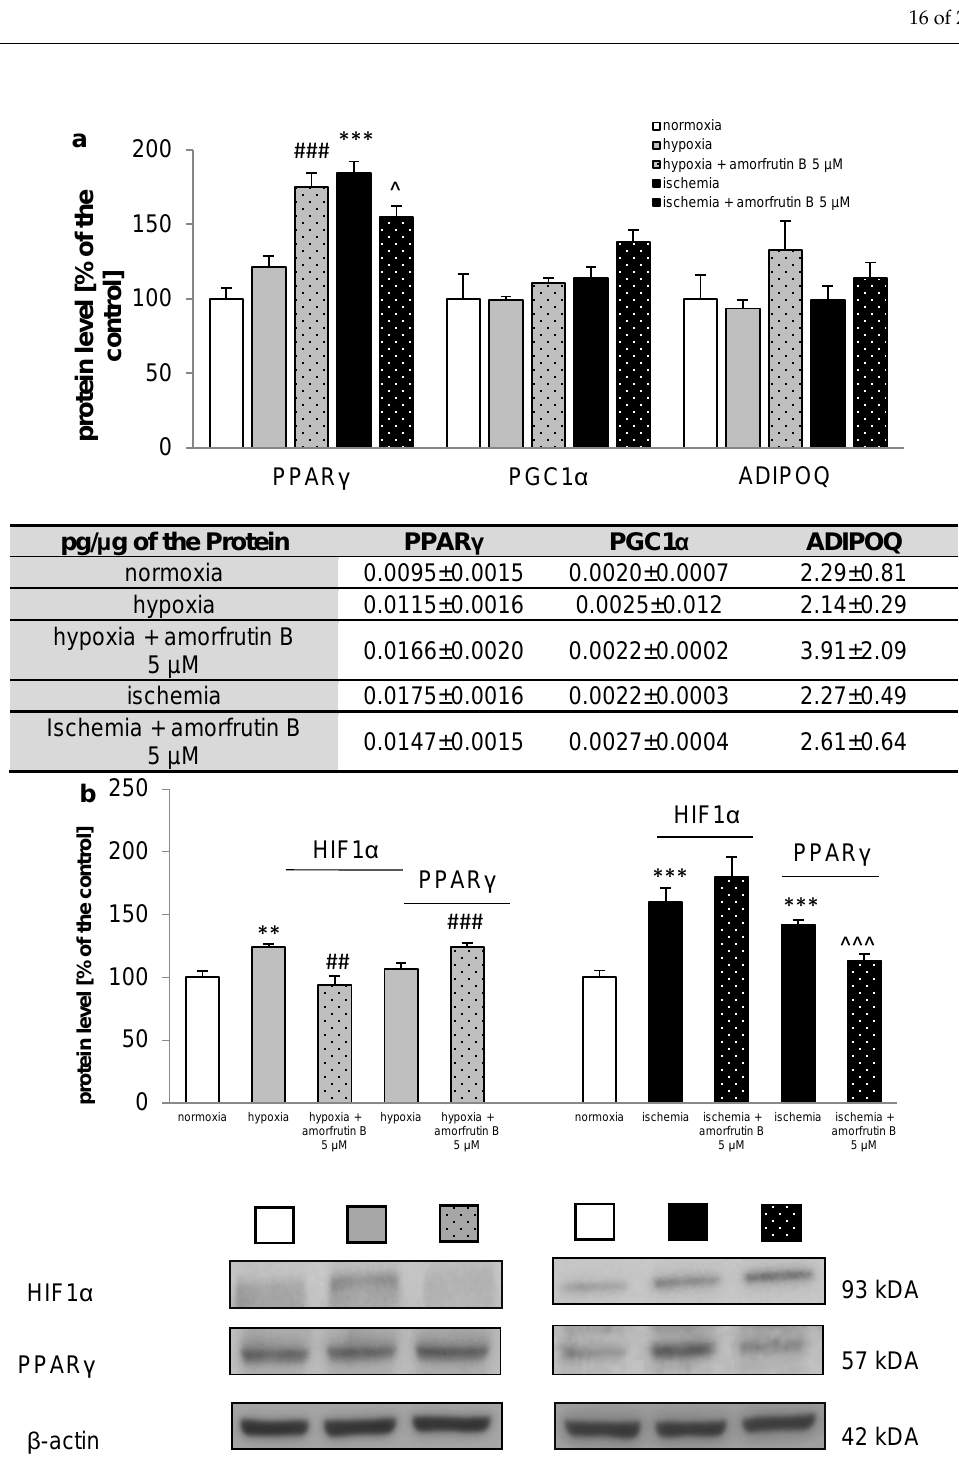
Figure 7. ELISA ( a ) and Western blot ( b ) showed that hypoxia or ischemia and amorfrutin B (5 µ M) post-treatment changed the protein expression levels of HIF1 α and PPAR γ but did not affect the protein expression levels of PGC1 α and ADIPOQ. The results are presented as a mean ± SEM. There were 3 independent experiments, consisting of 5–6 replicates per group. ** p < 0.01, and *** p < 0.001 compared to the control group, ## p < 0.01, ### p < 0.001 compared to the cultures exposed to hypoxia, ˆ p < 0.05, ˆˆˆ p < 0.001 compared to the cultures exposed to ischemia.